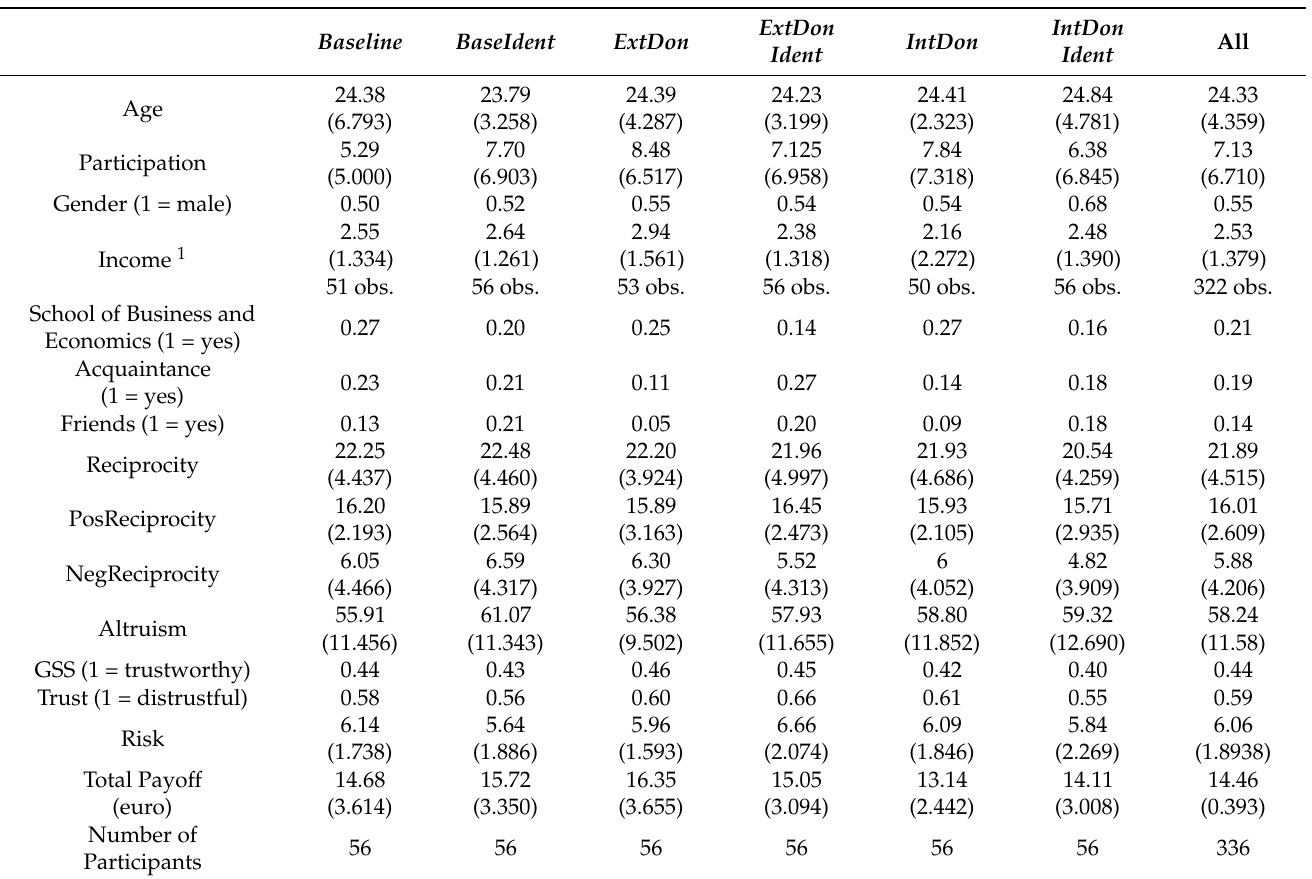
Table A1. General characteristics by